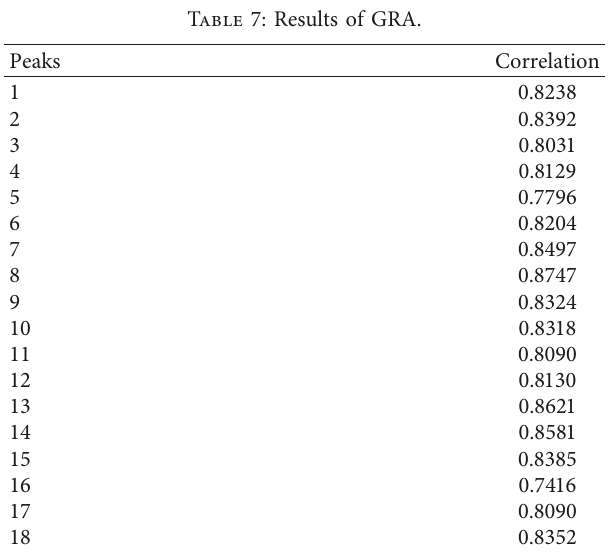
Table 7: Results of